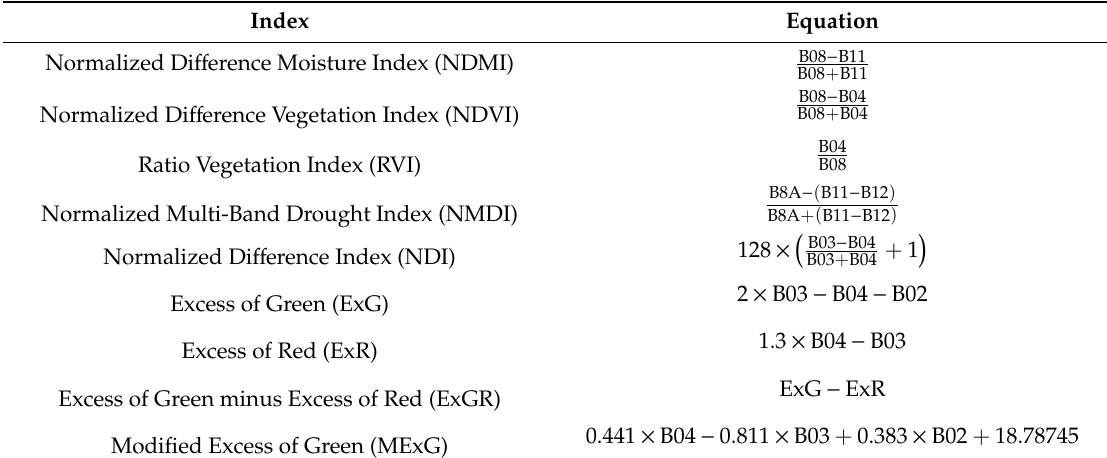
Table 1. Spectral indices equations.